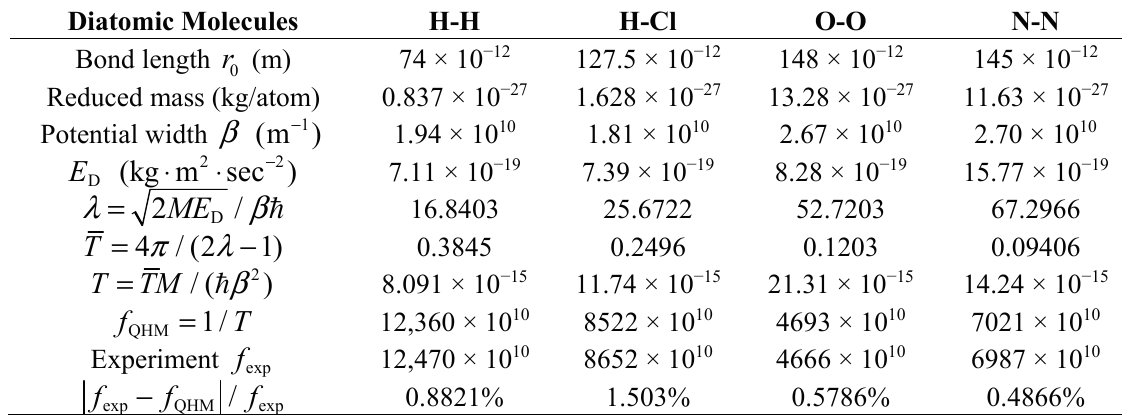
Table 1. Parameters of four diatomic molecules and the comparison of the computed with the measured frequency (cid:1858) . ground-state vibration frequencies (cid:1858) (cid:2901)(cid:2892)(cid:2897) (cid:2915)(cid:2934)(cid:2926) Diatomic Molecules H-H H-Cl O-O N-N r Bond length (m) 74 × 10 − 12 127.5 × 10 − 12 0 Reduced mass (kg/atom) 0.837 × 10 − 27 Potential width 1.94 × 10 10